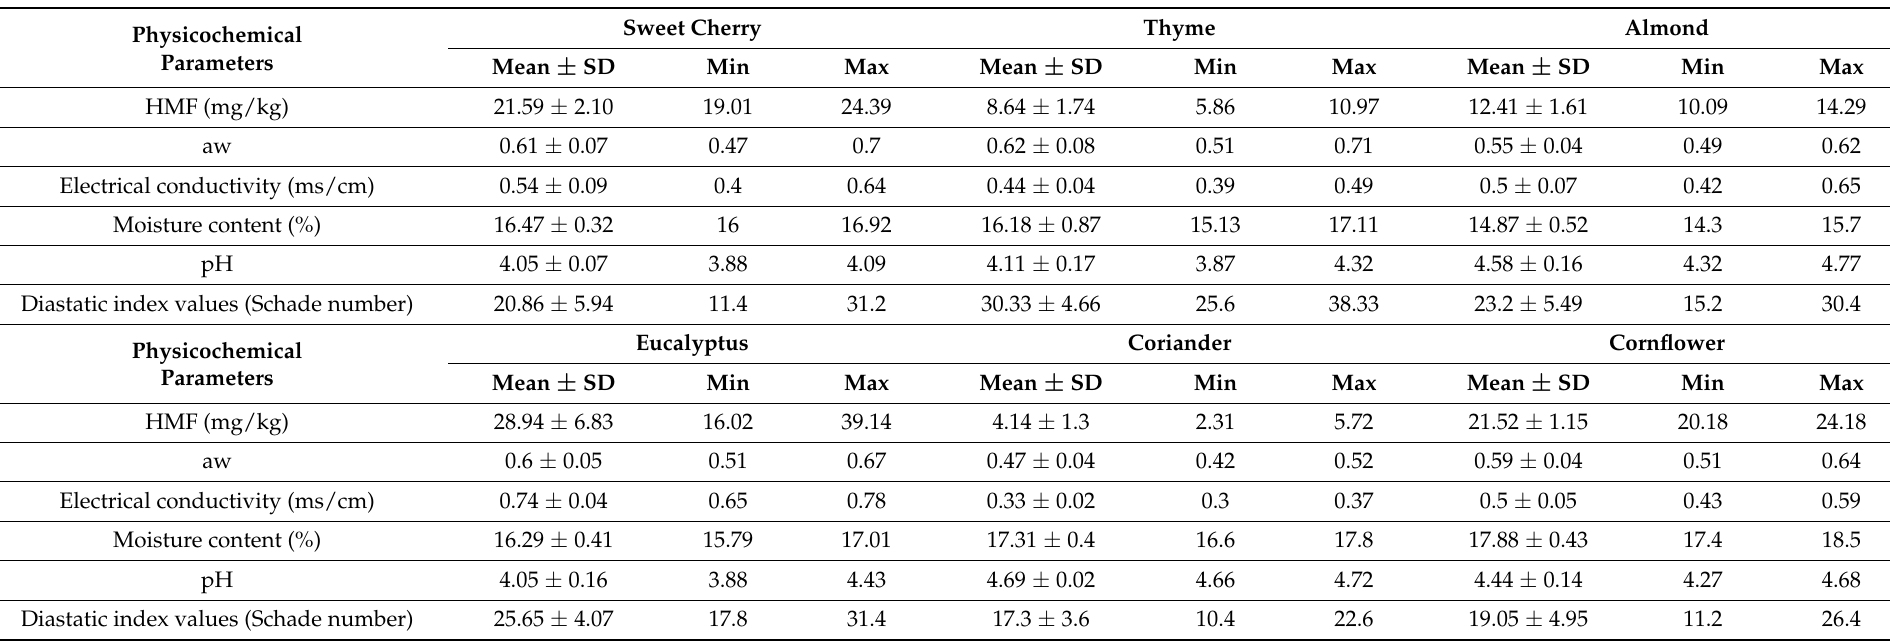
Table 2. Mean (and standard deviation), minimum and maximum values of the HMF, aw, electrical conductivity, moisture content, pH and diastatic index value of the Italian honey samples.